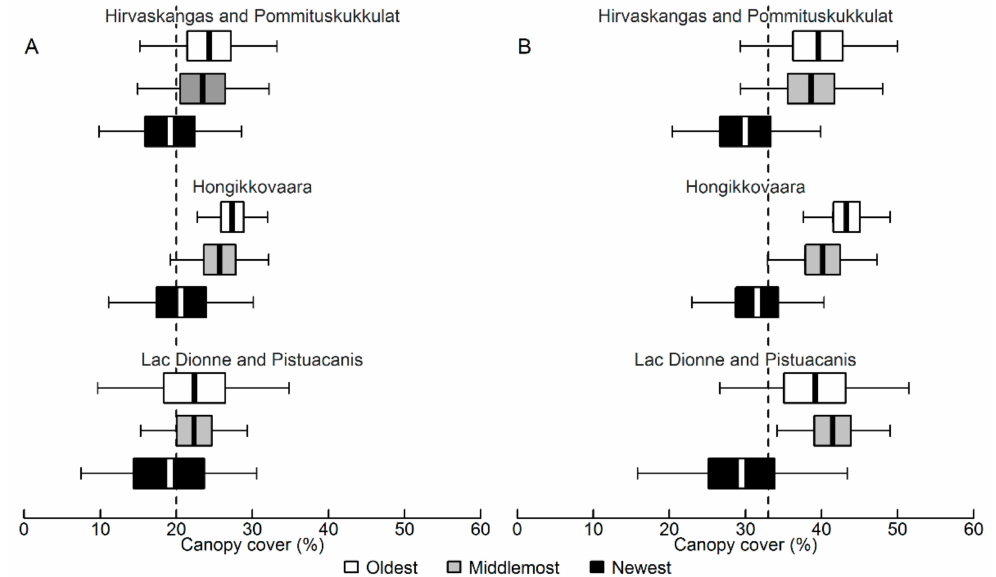
Figure 2. The canopy cover posterior predictive distributions for a cell for which canopy cover of 20% ( A ) or 33% ( B ) was interpreted at the time of the oldest (white), middlemost (grey) and newest (black) aerial photographs. The distributions are produced with models where only the interpreted canopy cover was used as a predictor (the comparison models for the newest photographs, calibration models for the other photographs). The whiskers indicate the 95% prediction